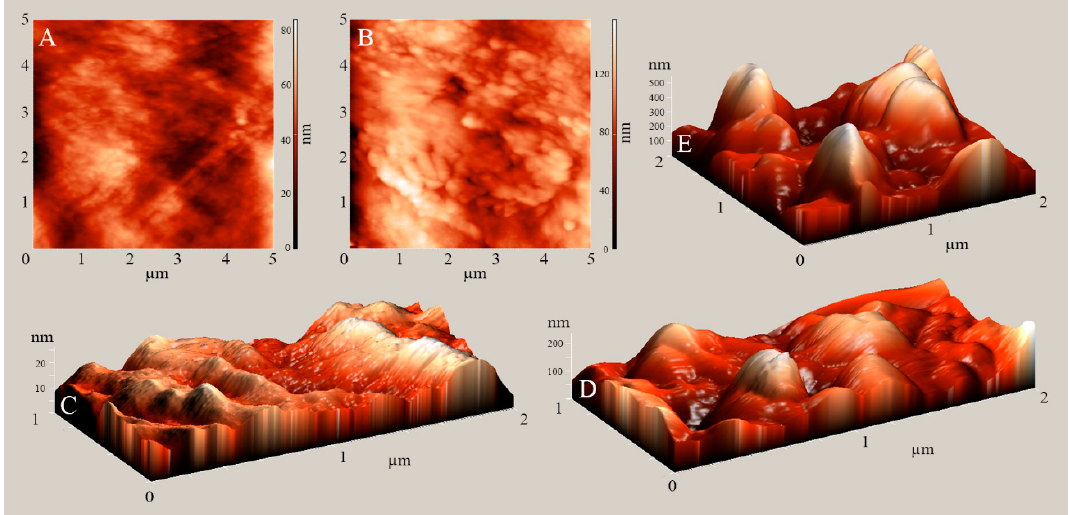
Figure 4. Atomic Force Microscopy (AFM) images of garlic clove surface, showing an area of 5 × 5 µm ( A , B ), 2 × 1 µm ( C , D ), or 2 × 2 µm ( E ). ( A , C ): untreated control; ( B , D ): plasma treatment at 30 Pa; ( E ): wax platelets visible on the sample treated at 30 Pa.